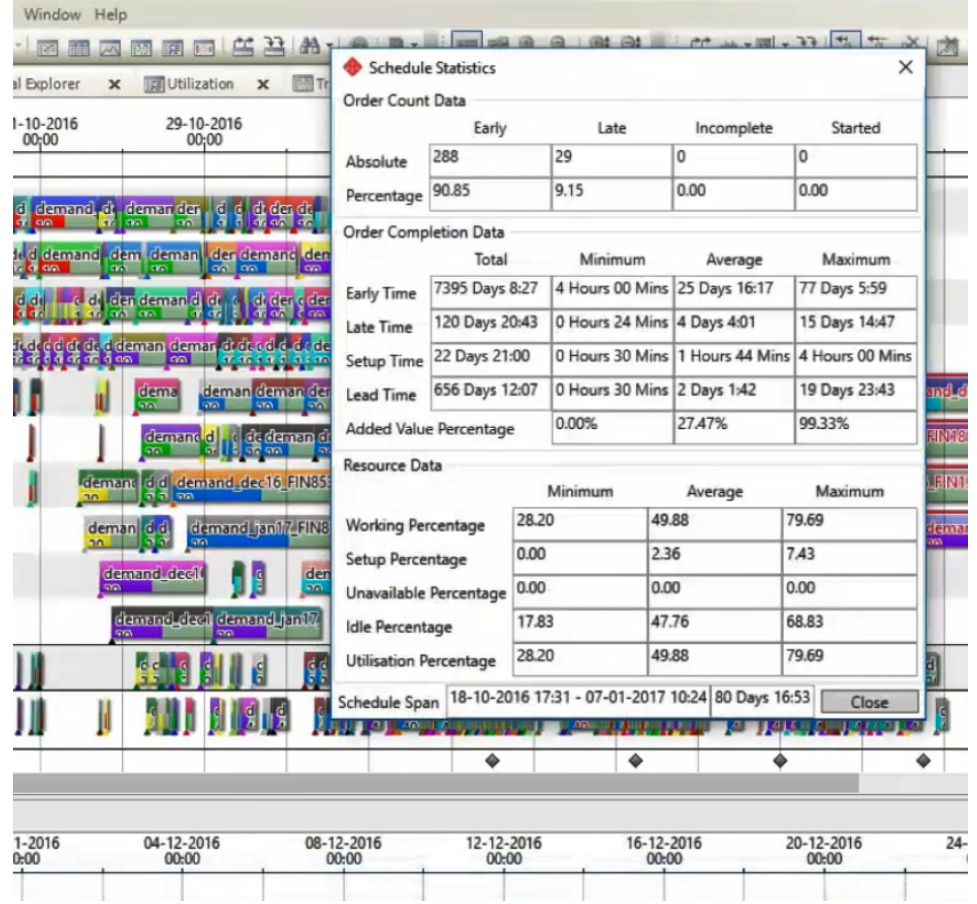
Figure 10. Forward scheduling with preferred sequence-Siemens Opcenter APS.